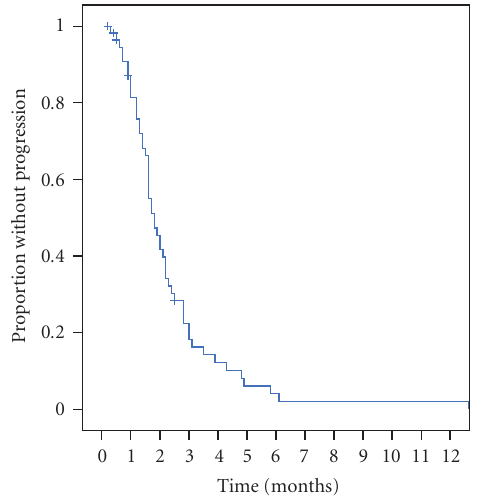
Figure 2: Overall survival for patients receiving vinorelbine on this study (+ indicates censored